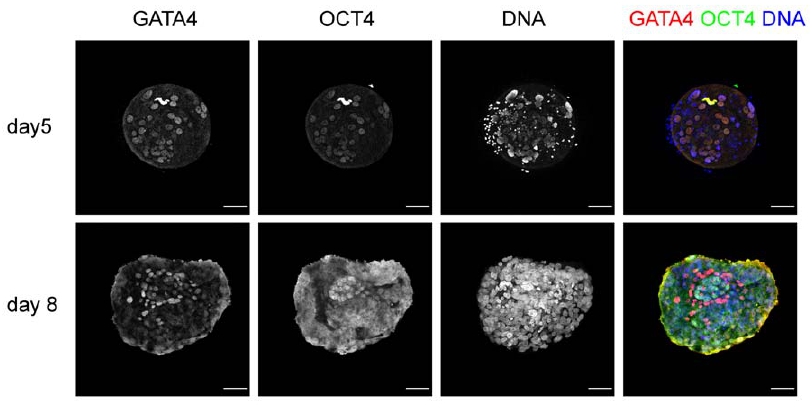
Figure 2. Lineage development in human embryos. Expression of OCT4 and GATA4 in day 5 embryos and in embryos that have been co- cultured with decidualized endometrial cells for 72 h. Scale bars are 50 m m.